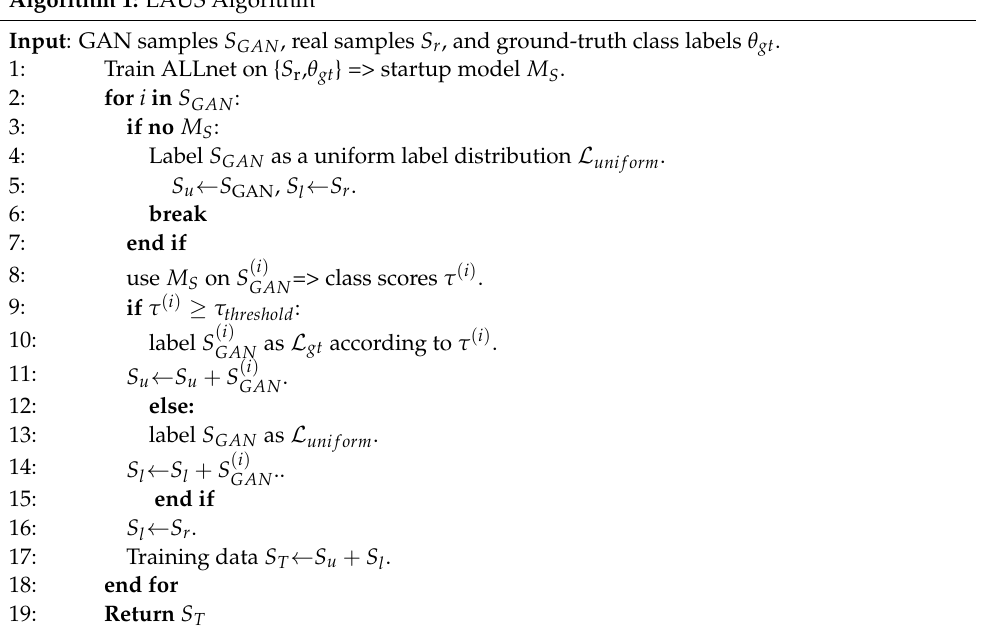
Algorithm 1: LAUS